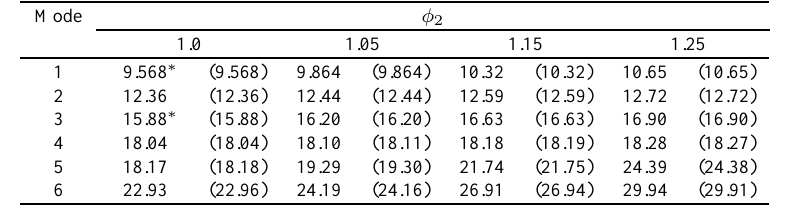
values obtained from Multi-Span Approach, in brackets ( ∗ indicates classical